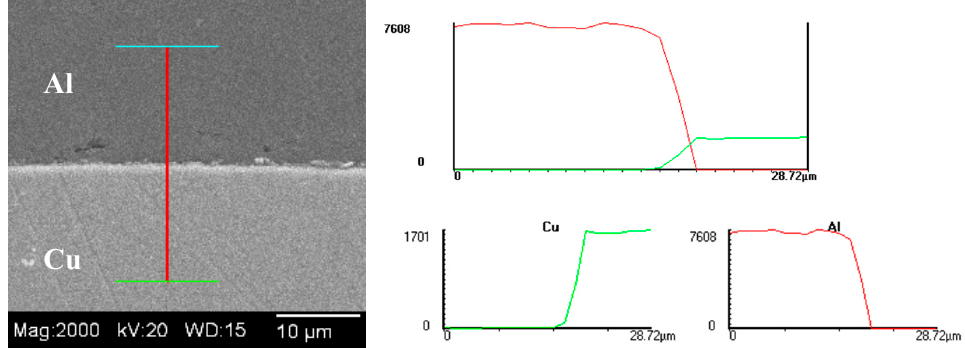
Figure 4. Energy-dispersive X-ray spectroscopy (EDS) line scan across the interface of the Al/Cu joint: showing an obvious interdiffusion of the Al and Cu.